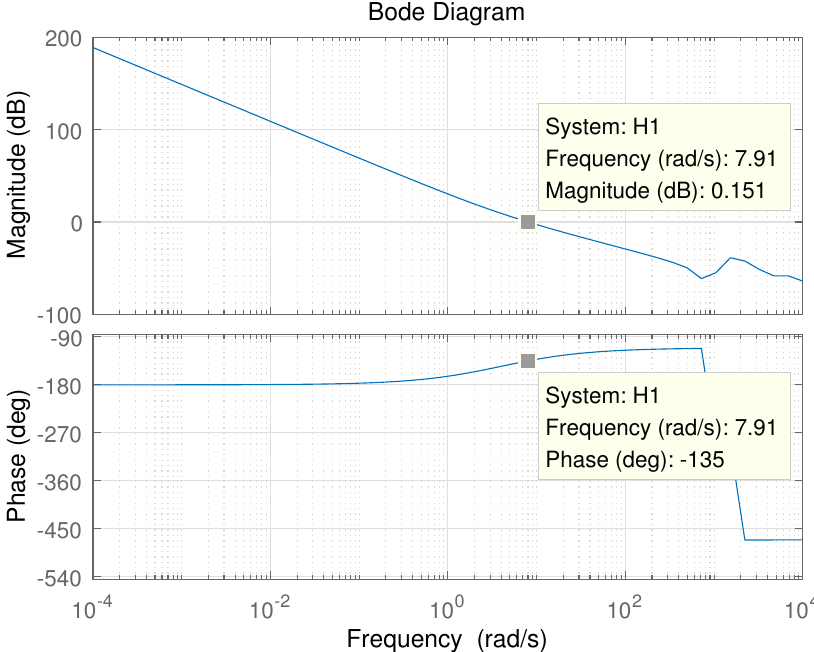
Figure 3. The Bode diagram under the fractional-order PD controller K p = 1408.5, K d = 488.1, α = 0.77.